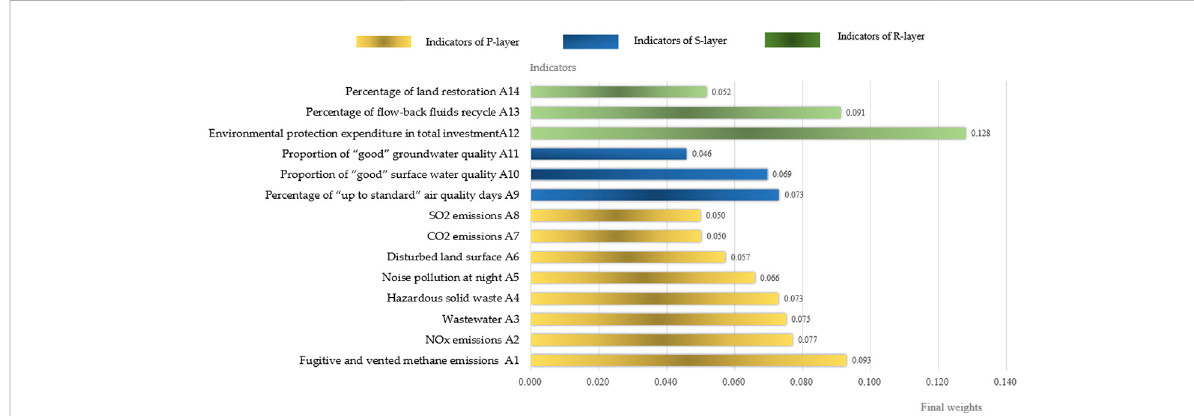
FIGURE 5 The fi nal weights of fourteen tailored indicators of Changning play.